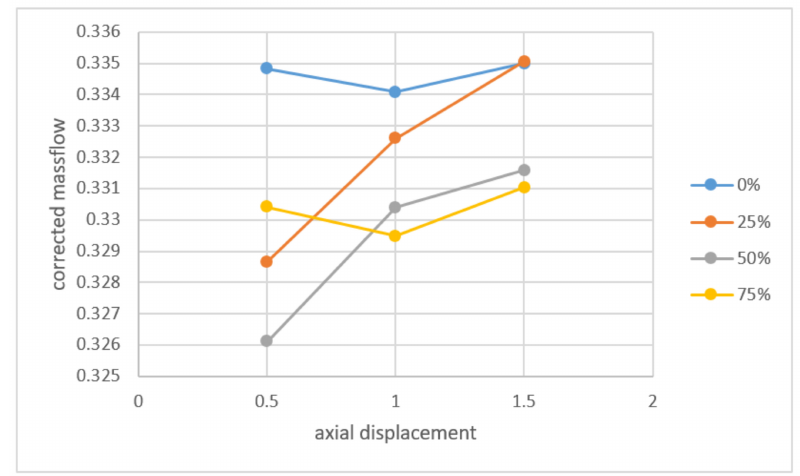
Figure A2. Corrected mass flow as a function of gap and